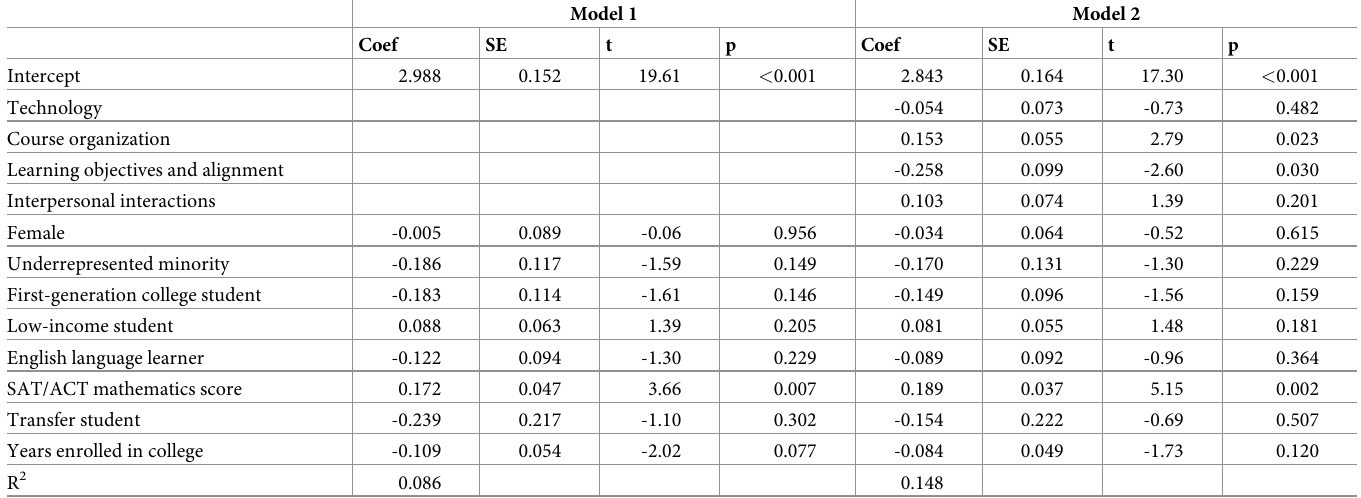
Table 4. Multiple linear regression analysis on student grades with clustered standard errors, N =